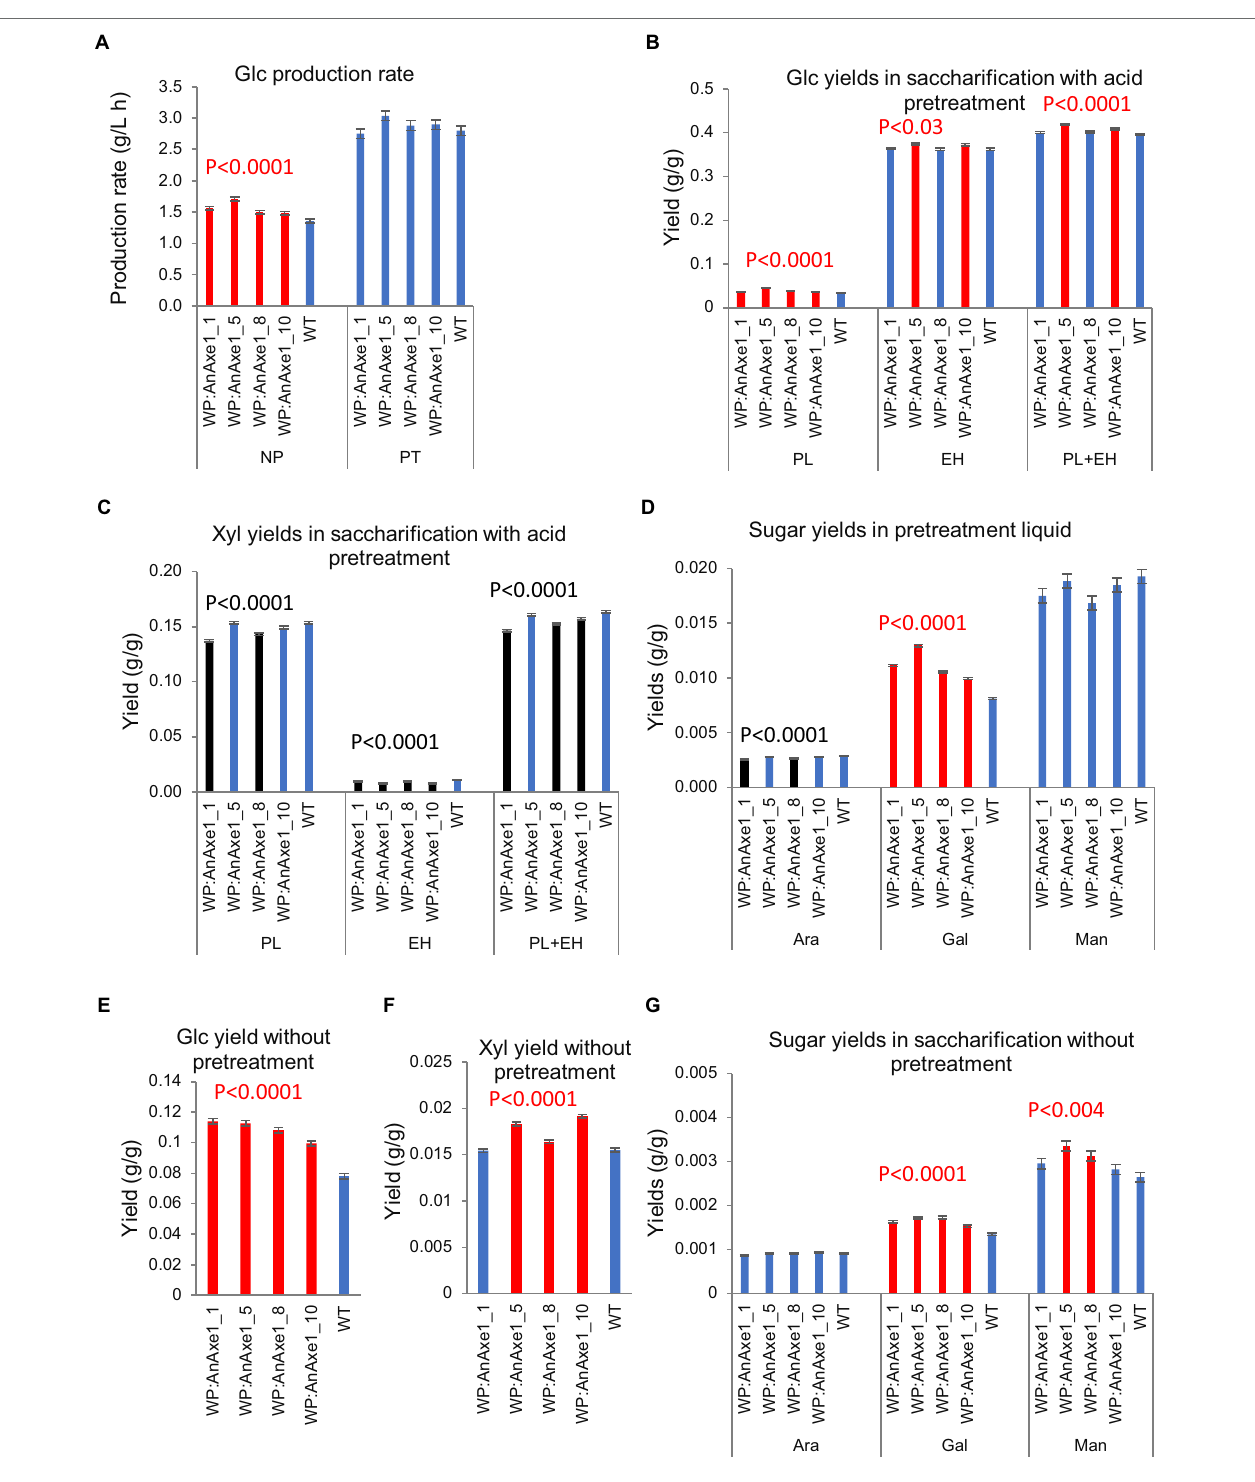
FIGURE 2 | Saccharification parameters of developing wood from transgenic greenhouse-grown aspen expressing wood-promoter driven AnAXE1 ( WP:AnAXE1 ). (A) Glucose production rates in saccharification without (NP) and with (PT) acid pretreatment. Yields of glucose (B) , xylose (C) , and minor sugars (D) in saccharification with acid pretreatment. PL, pretreatment liquid; EH, enzymatic hydrolysis; and PL + EH, total sugar yield. Yields of glucose (E) , xylose (F) , and minor sugars (G) in saccharification without pretreatment. Means ± SE of three biological replicates. Significant differences according to ANOVA followed by Dunnett’s test ( p < 5%) are indicated by color (red – higher and black – lower, than WT parameters). The values of p show the significance of differences between all the lines carrying indicated constructs and WT plants (post-ANOVA contrast, shown when <